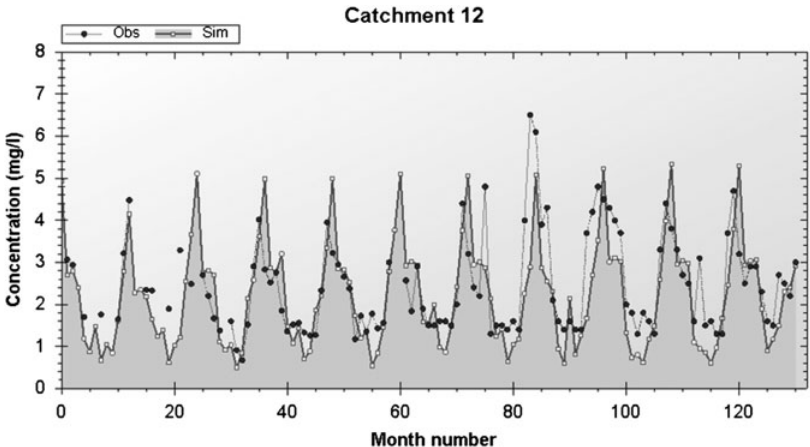
Fig. 6. Modeled and observed total nitrogen concentrations in FyrisNP model